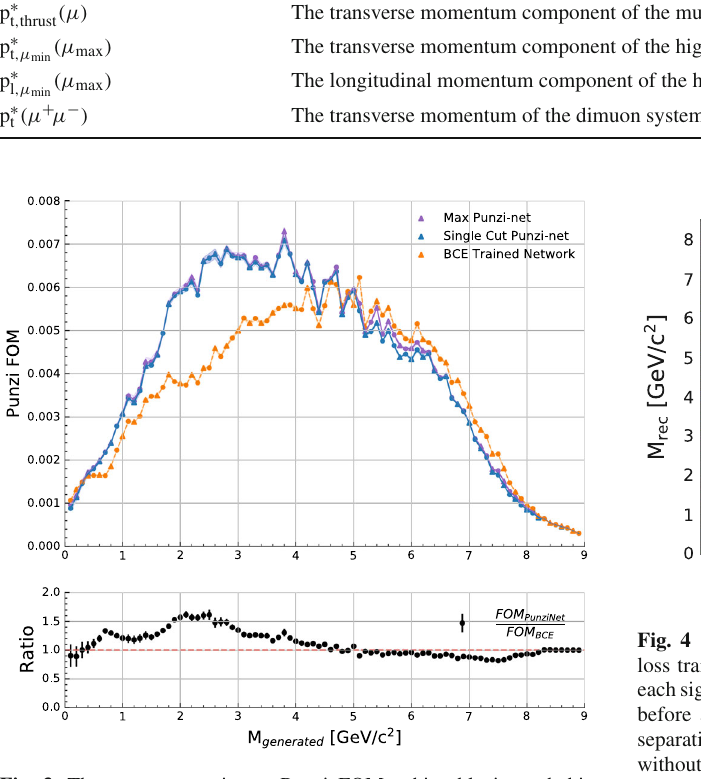
Fig. 3 The average maximum Punzi FOM achievable in each bin across range of generated Z (cid:2) signals, with standard error spread taken from 10 independently trained networks. Triangles indicates those masses which were left out of training while circles indicates those used